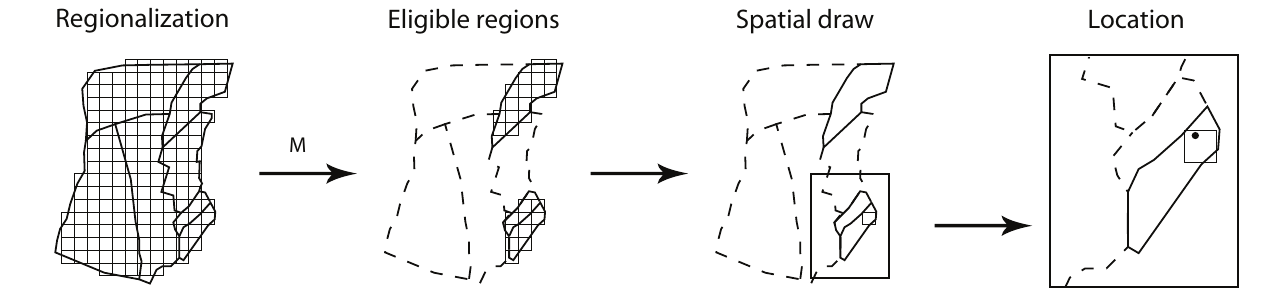
Figure 2. General workflow of main shocks localization. A probability map is defined through a Cartesian grid. Each region is characterized by their own probability map and maximal magnitude allowed. The magnitude M of the generated main shock limits the number of eligible regions. Spatial drawing is then realized only within eligible regions. Once a cell of the grid is drawn, epicentral coordinates of the main shock (black point) are uniformly drawn within this